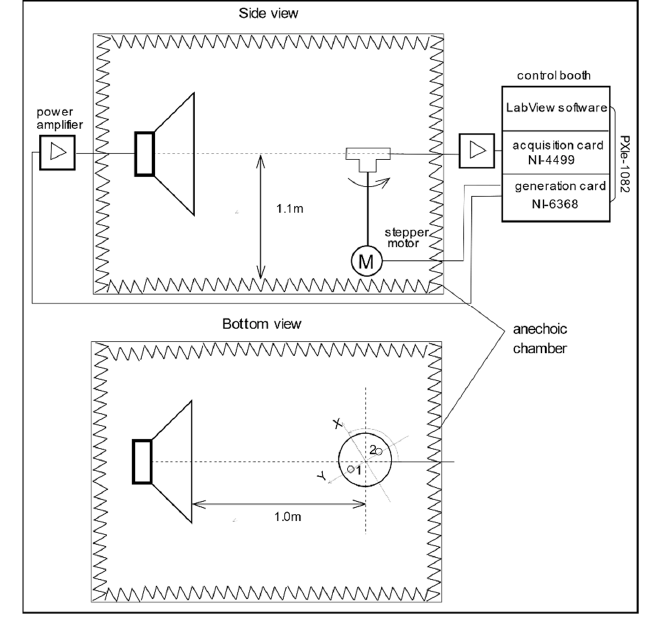
Figure 3. Experimental measuring workplace.